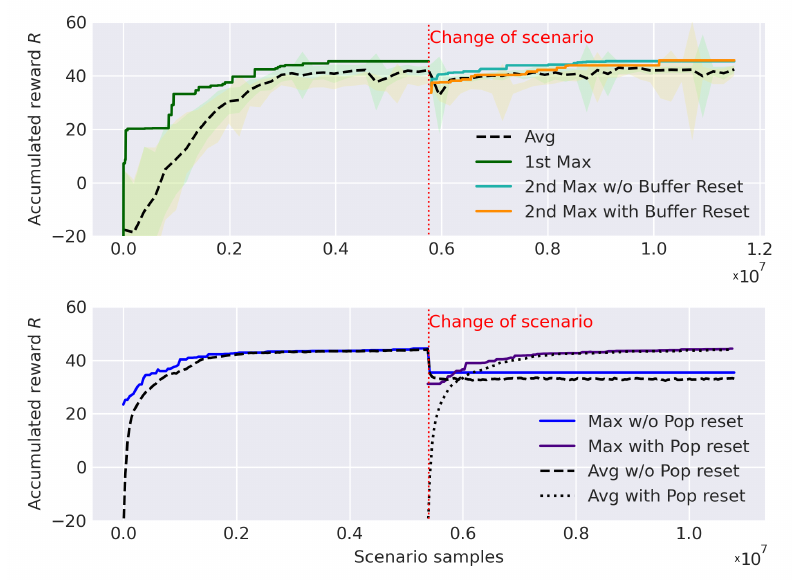
Figure 17. Result of the optimization with a change in the interest map for DDQL ( up ) and EA ( down ).